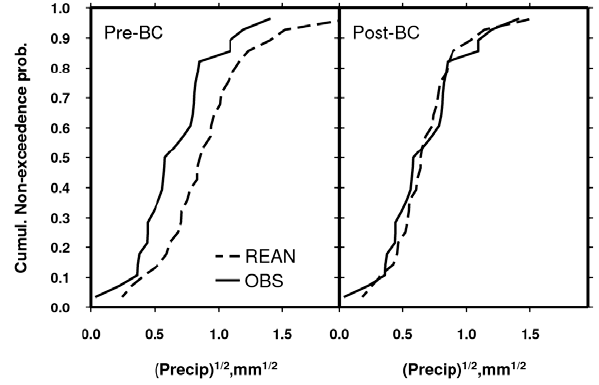
Fig. 4. CDFs for the same grid cell as in Fig. 3, but based on Figure 4. CDFs for the same grid cell as in Figure 3, but based on monthly average 2 monthly average precipitation rate data for January for the “ob- precipitation rate data for January for the “observed” period 1950-1976. 3 served” period